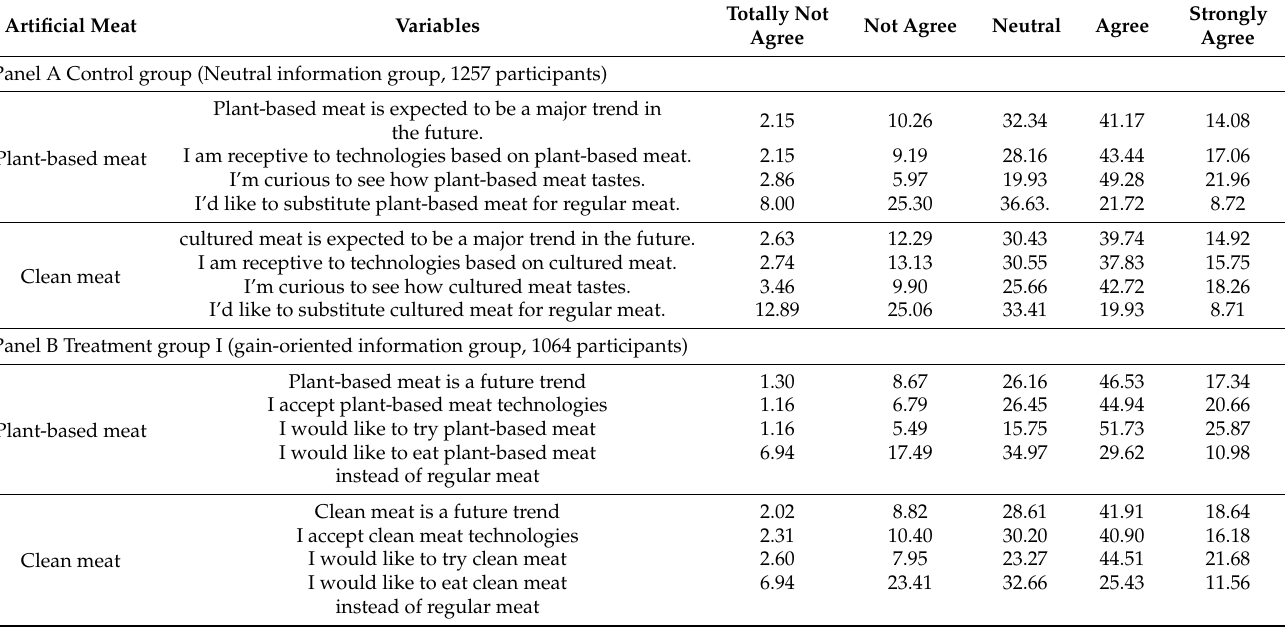
Table A4. Frequency distributions of respondents’ acceptance toward artificial meat across informa- tion